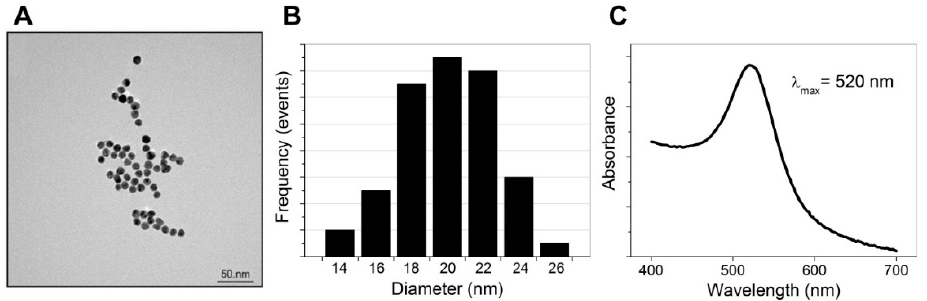
Figure 3. TEM image ( A ), size distribution ( B ), and UV ‒ vis absorbance spectrum ( C ) of the AuNPs. Table 2. Data from TEM (physical diameter), DLS (hydrodynamic diameter), and ζ -potential characterization of AuNPs.